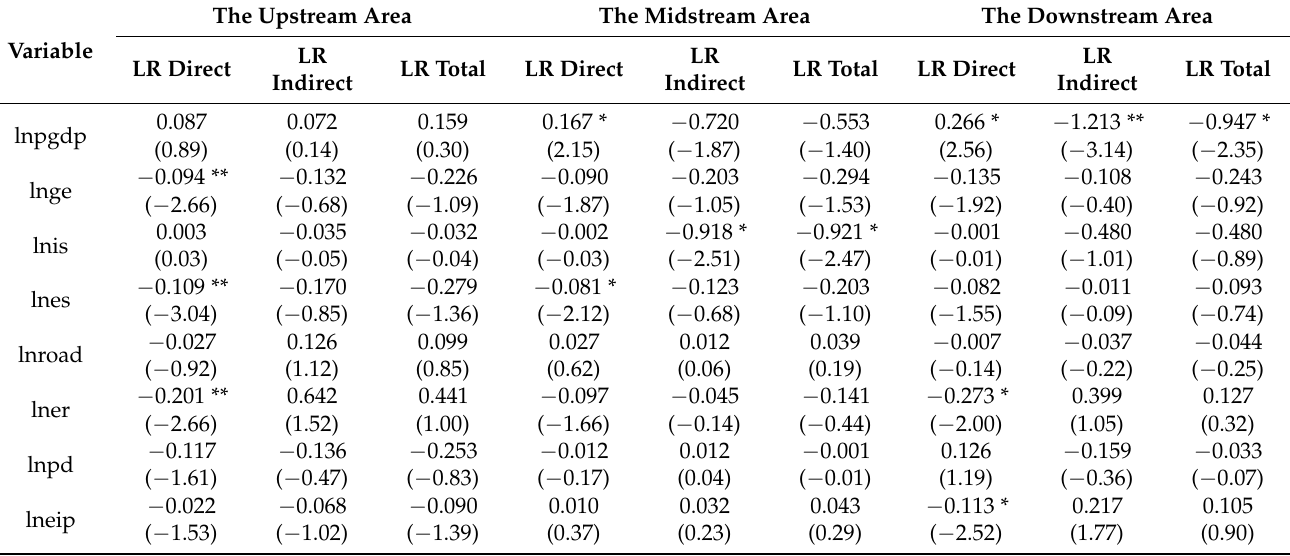
Table 9. Heterogeneity Test results of the SDM